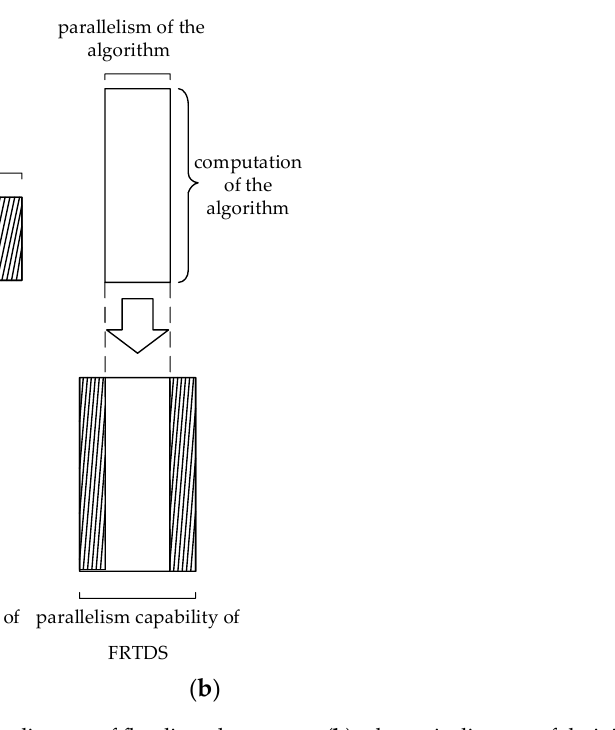
Figure 10. ( a ) Schematic diagram of flooding phenomena; ( b ) schematic diagram of draining phe-